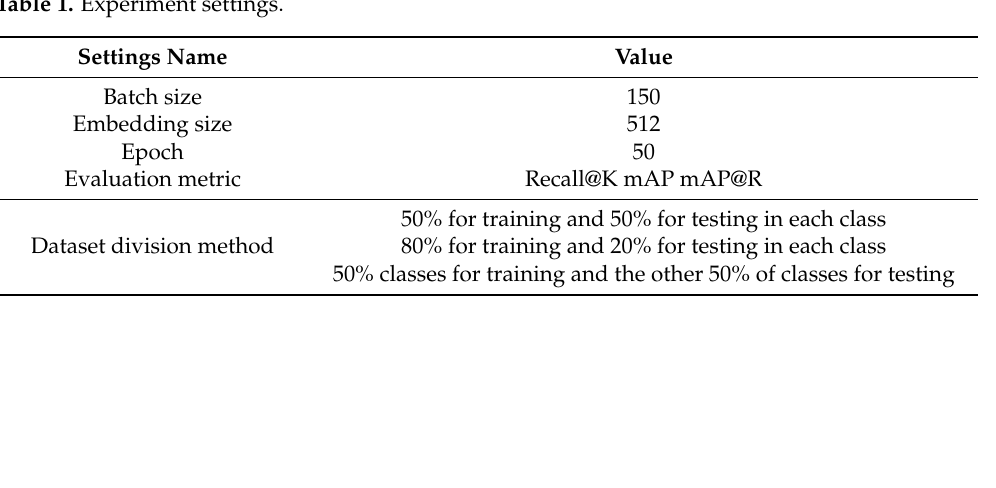
Table 1. Experiment